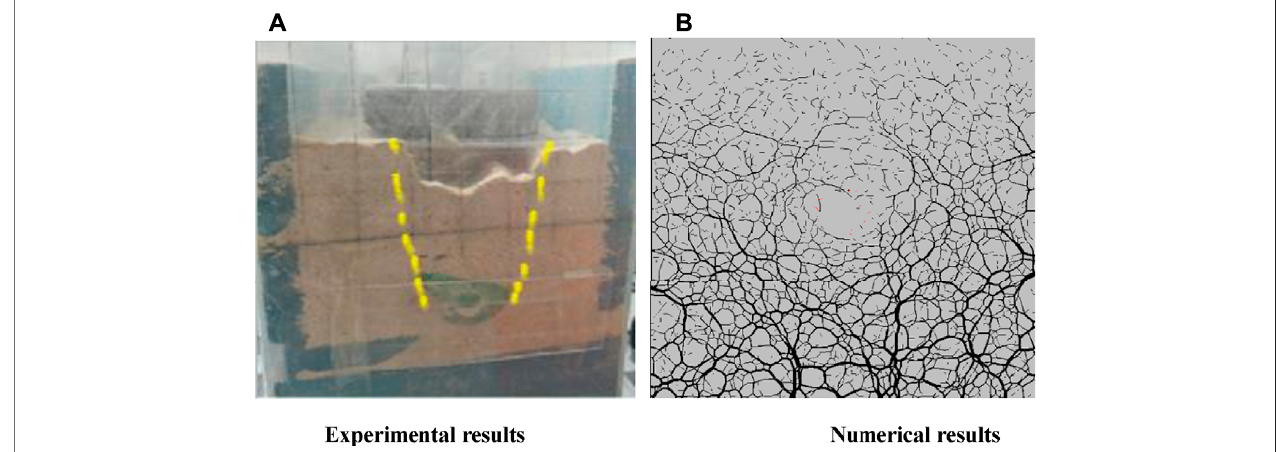
FIGURE 12 | Experimental and numerical results of 15 m deep tunnel after earthquake. (A) Experimental results. (B) Numerical results.